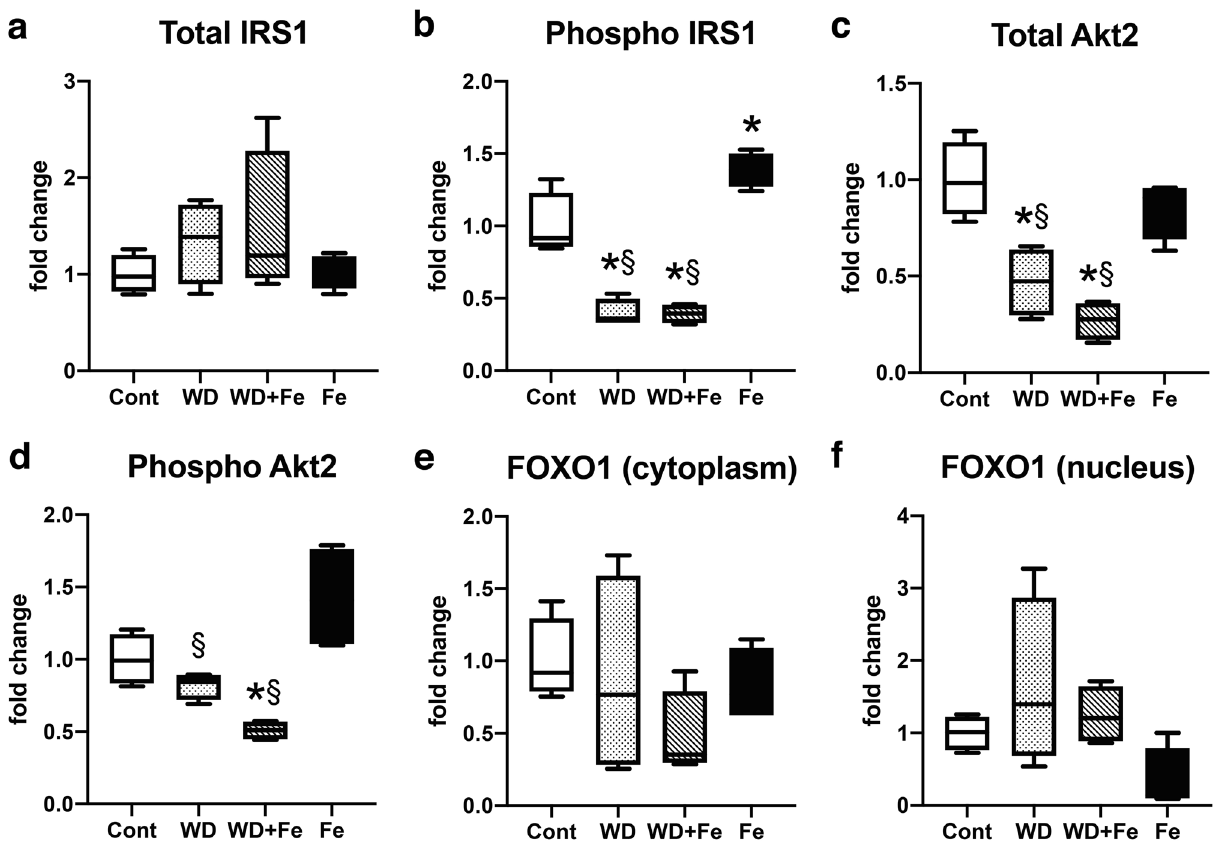
Figure 5. Hepatic expression of ( a ) total IRS1, ( b ) phospho-IRS1(Tyr 612), ( c ) total Akt2, ( d ) phospho-Akt2 from the whole liver tissue lysate at week 26. Hepatic expression of FOXO1 expression in the ( e ) cytoplasmic and ( f ) nuclear fractions at week 26. GAPDH and histone H2B were used for a loading control in the whole tissue/cytoplasmic and nuclear fraction, respectively. Data are expressed as fold change from control and are presented as box and whiskers (n = 4/group). * P < 0.05 versus Cont, and § P < 0.05 versus Fe by one-way ANOVA followed by Tukey’s multiple